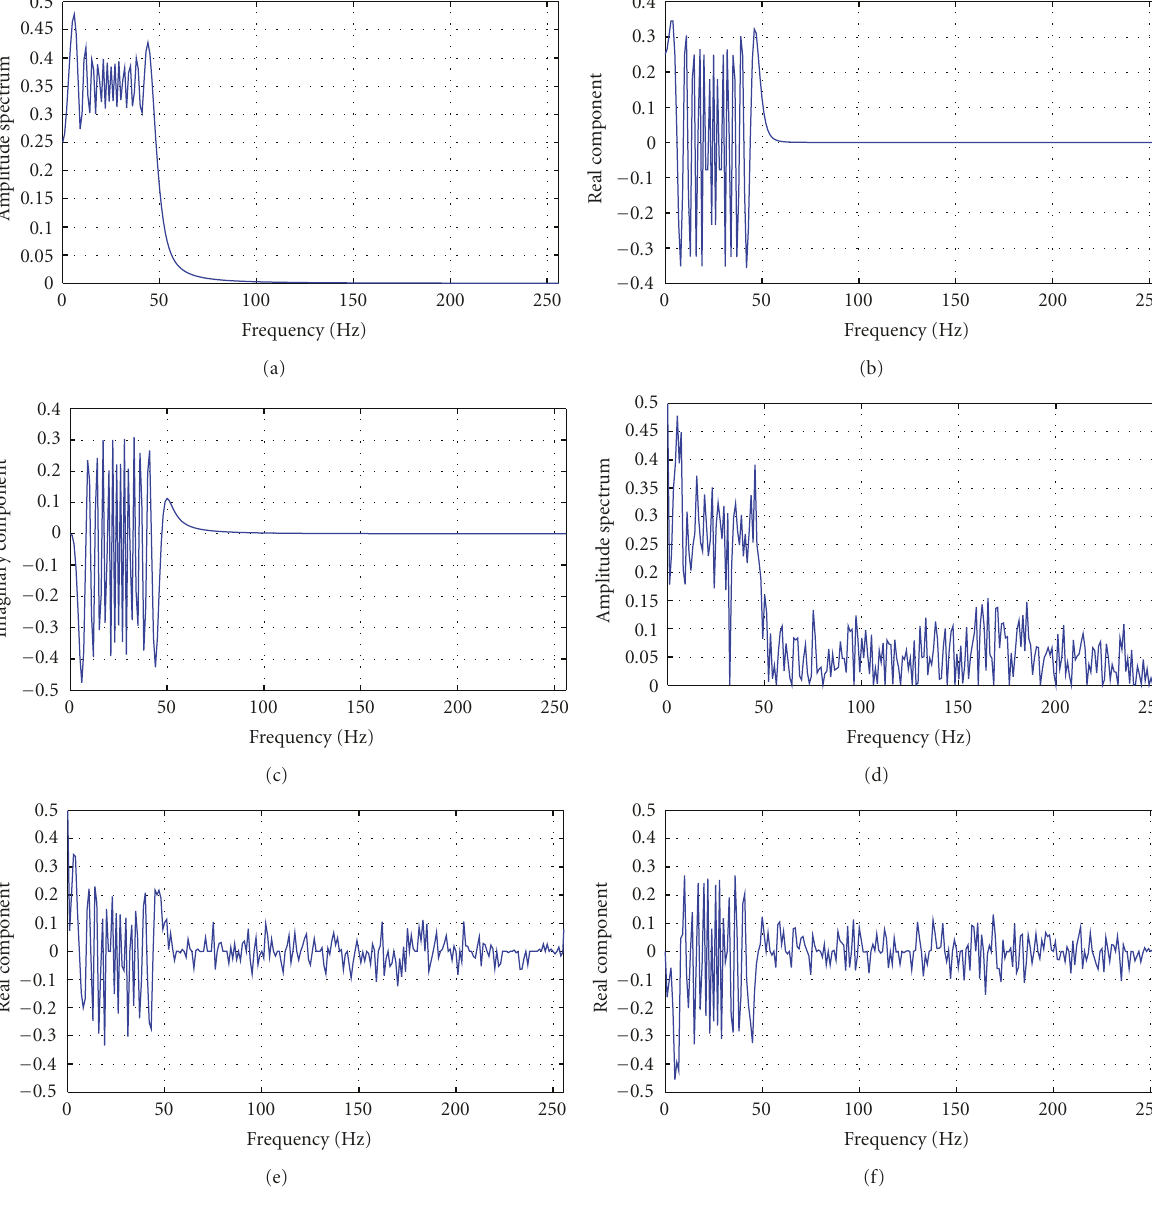
increased in comparison to those presented in Figure 10. The values PCK RE ( p ) and PCK IM ( p ) (except p = N/ 2 = 256) are approximately equal, but have decreased compared to Figure 10. They are now approximately equal to 0.2, that is, the PDF su ffi ciently di ff ers from the Gaussian distribution and has heavy tails. This implies that even when noise tail heaviness is known in advance, the characteristics of noise in R ( p , n ) and I ( p , n ) described by PCK RE ( p ) and PCK IM ( p ) can vary depending upon SNR. Then, one has to adapt to distribution characteristics of R ( p , n ) and I ( p , n ) in order to provide accurate spectral estimation and